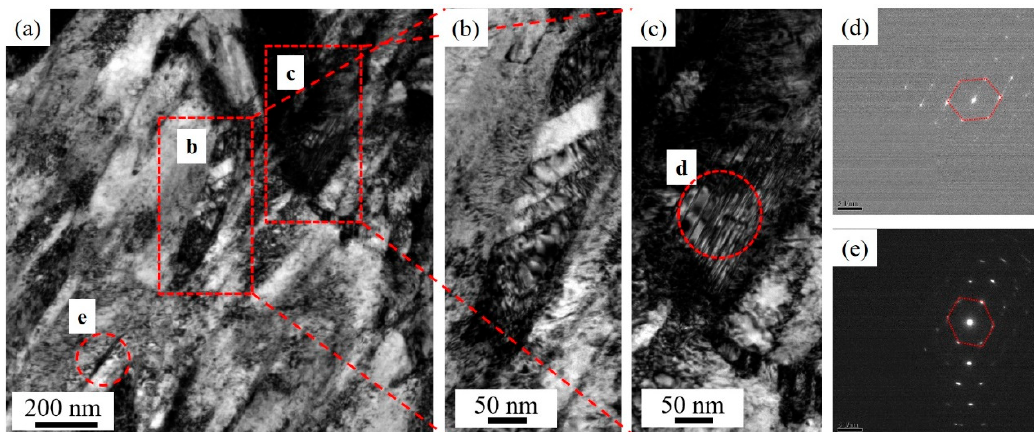
Figure 8. ( a ) TEM images of the microstructure near the fracture in W-QT&P300. ( b ) A typical deformed microstructure of martensite lath with transgranular bands. In ( b , c ) are enlarged images of the rectangles in ( a ). The SAED pattern ( d , e ) show the existence of both small blocky austenite and film austenite, respectively.